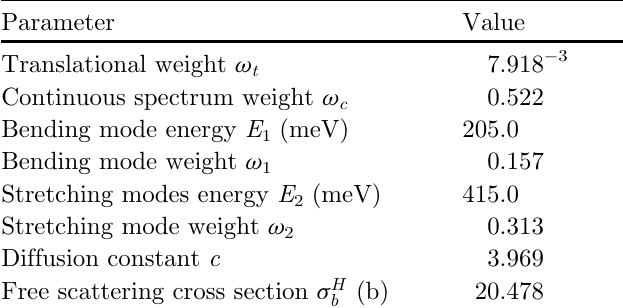
Table 2. CAB model parameters introduced in the LEAPR module [8] for 1 H in HO at 294 K